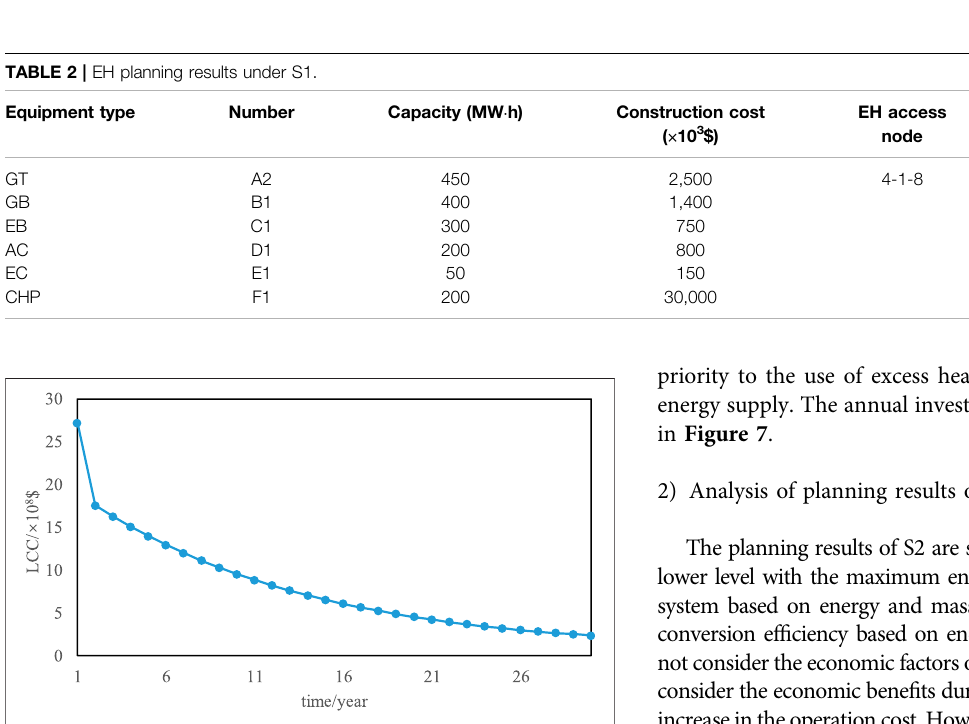
FIGURE 6 | Daily load of a typical scenario.